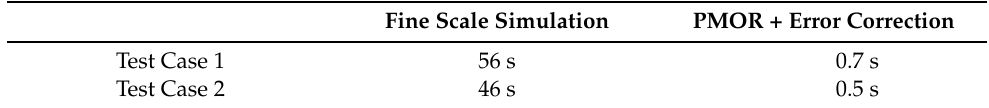
Table 12. Time (seconds) comparison for the two test cases (lower-dimensional basis) between fine-scale simulation and reduced-order model with error correction.